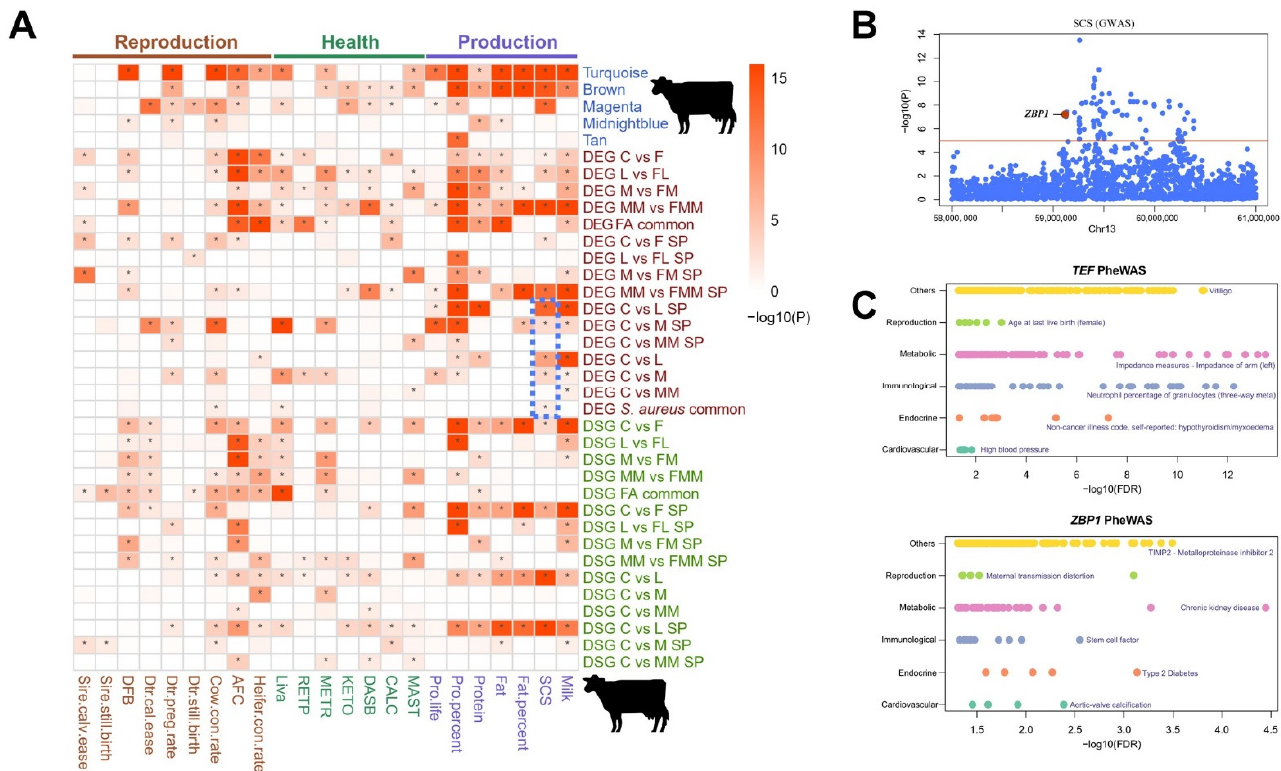
Figure 7. Characterization of GWAS signal enrichment and Phe-WAS. ( A ) GWAS enrichment analysis in bovine large- scale GWAS data (* p < 0.05). SP: specific DEGs or DSGs in a comparison set; MAST: mastitis; CALC: Hypocalcemia; DASB: Displaced abomasum; KETO: Ketosis; METR: Metritis; RETP: Retained placenta; Liva: Livability. ( B ) Significant GWAS signal of bovine SCS trait found around bovine ZBP1 . ( C ) Phe-WAS analyses of the important candidate genes ( ZBP1 and TEF ) in human large-scale phenotypic data.